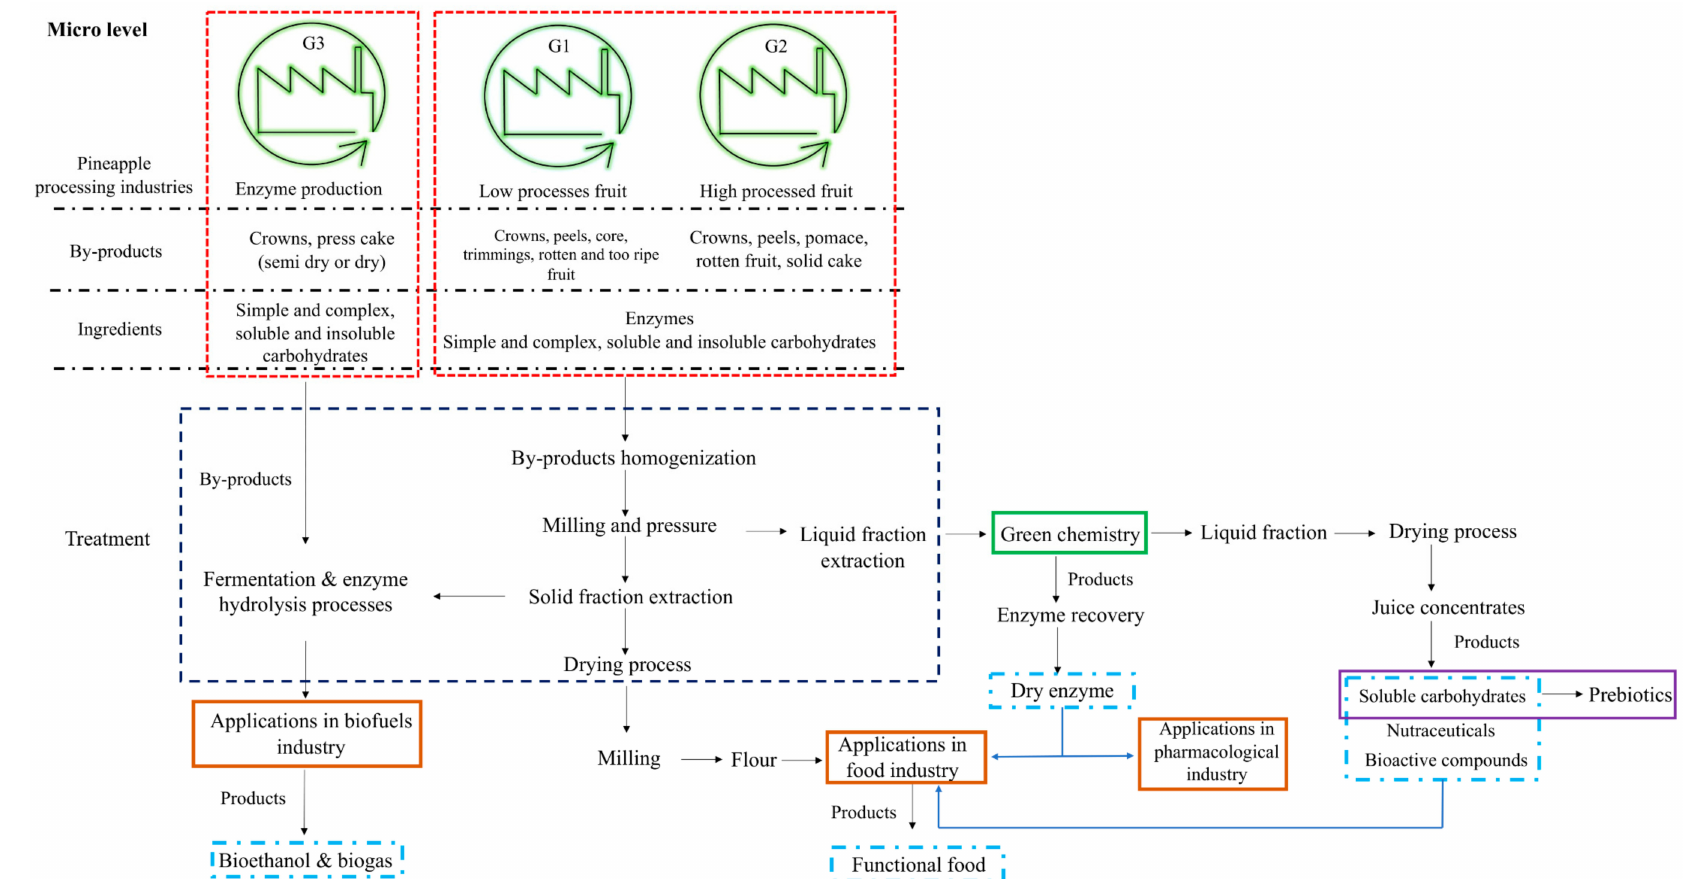
Figure 1. Implementation of circular economy at a micro level for pineapple processing